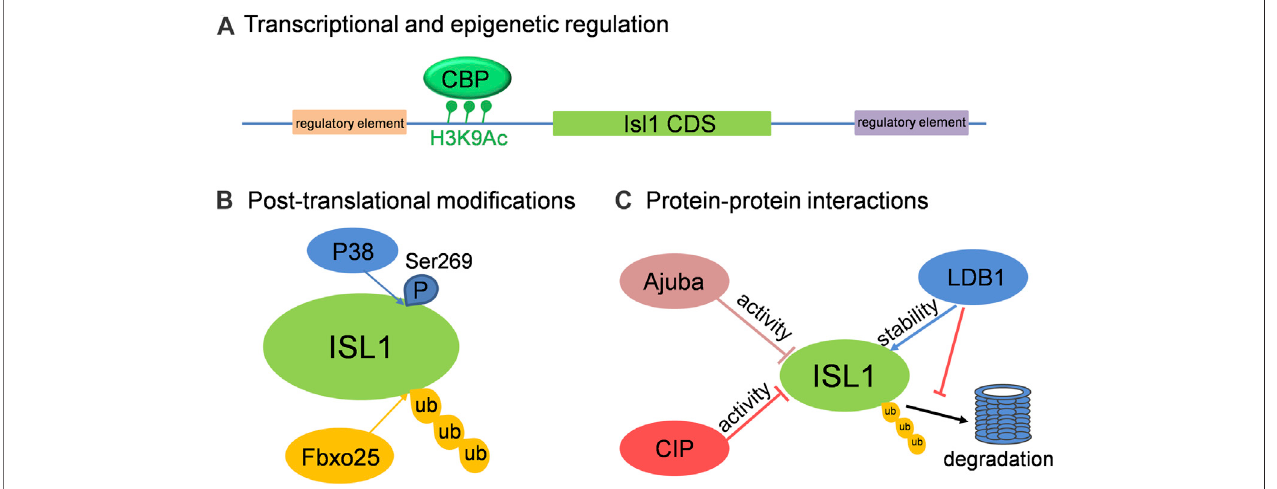
FIGURE2| Thecellular and molecularregulation onIsl1 incardiovasculardevelopment. (A) Isl1 canbe regulated at transcriptional level bybinding ofregulators on the regulatory elements located up- or down-stream of Isl1, or by histone modi fi cation on Isl1 promoter region. (B) ISL1 can be ubiquitinated by Fbxo25 and phosphorylated by P38. (C) The transcriptional activity and stability of ISL1 can be regulated by its interaction partners, such as CIP, Ajuba and LDB1.